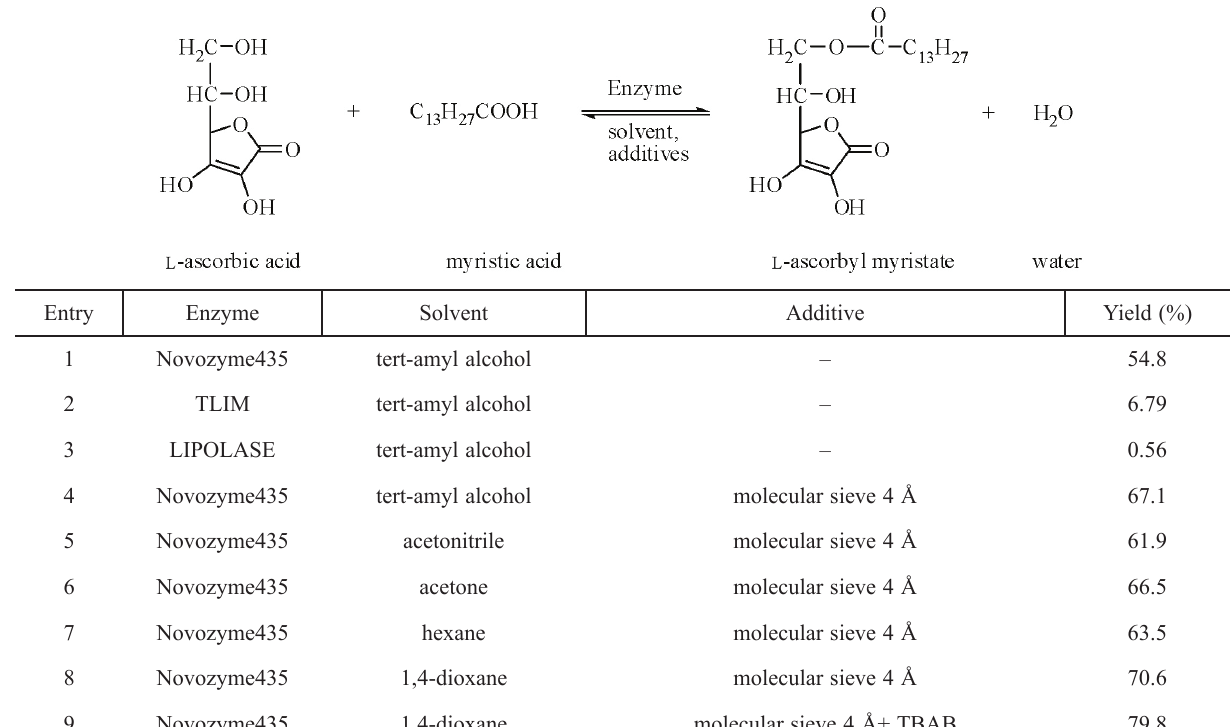
Table 1 – Effect of enzymes, solvents, additives on the enzymatic synthesis of l -ascorbyl